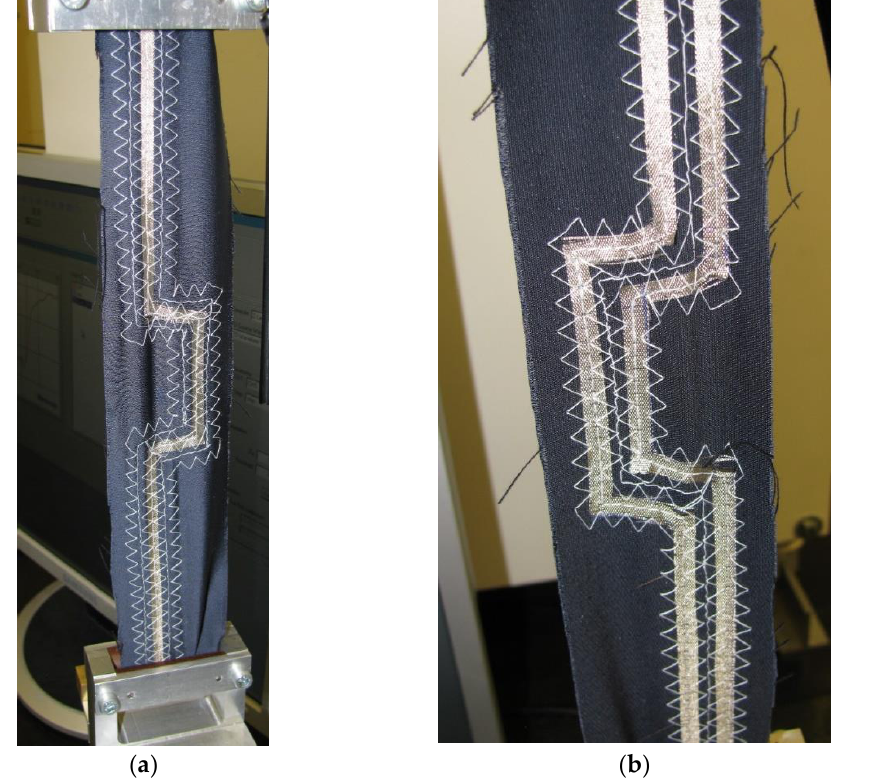
Figure 5. Textile signal line mounted vertically with load m 2 = 1.461 kg placed to the end of the line. View from the side of the signal path ( a ), View from the side of the ground paths ( b ).